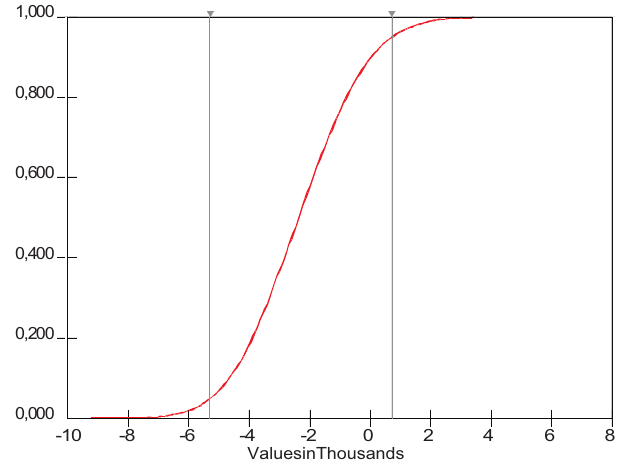
Fig. 6. The distribution function of net present value of apple growing-cool storage system, without state